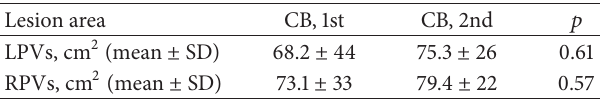
Table 4: Comparison of lesion area between the first- and second- generation CryoBalloon catheter. Data obtained from electroana- tomic mapping performed after cryoablation using the NavX system (St. Jude Medical, St. Paul, MN, USA).